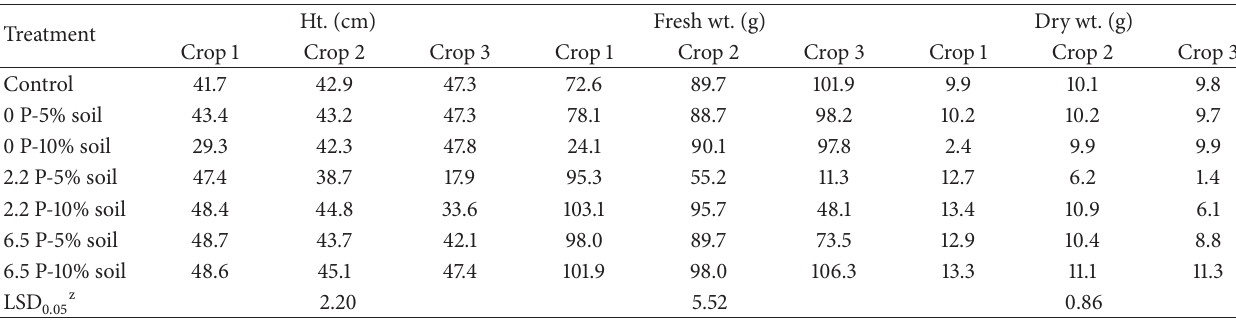
Table 1: Tomato shoot height, fresh weight, and dry weight at the end of three successive seedling crops grown in root media amended with no soil material (control) and six soil material treatments combinations containing 5 or 10% soil material (v/v) charged with 0, 2.2, or 6.5 mg ⋅ g −1 phosphate-P y